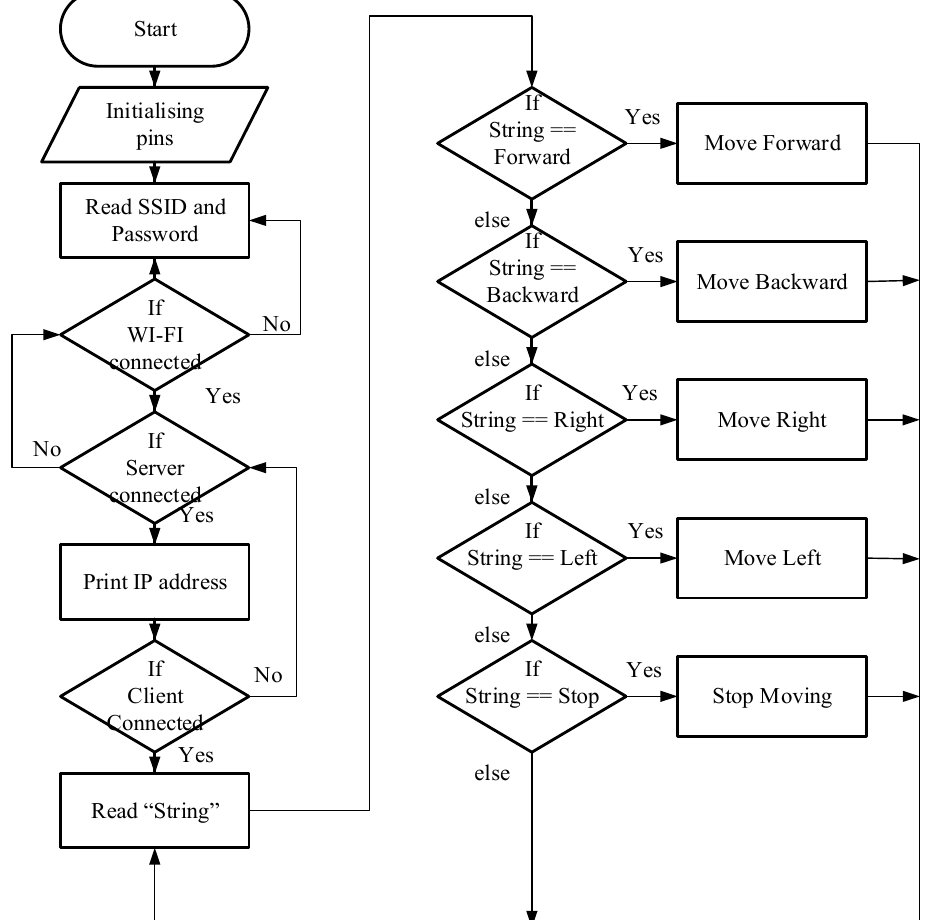
Figure 5. Remote control flowchart of the mobile platform.